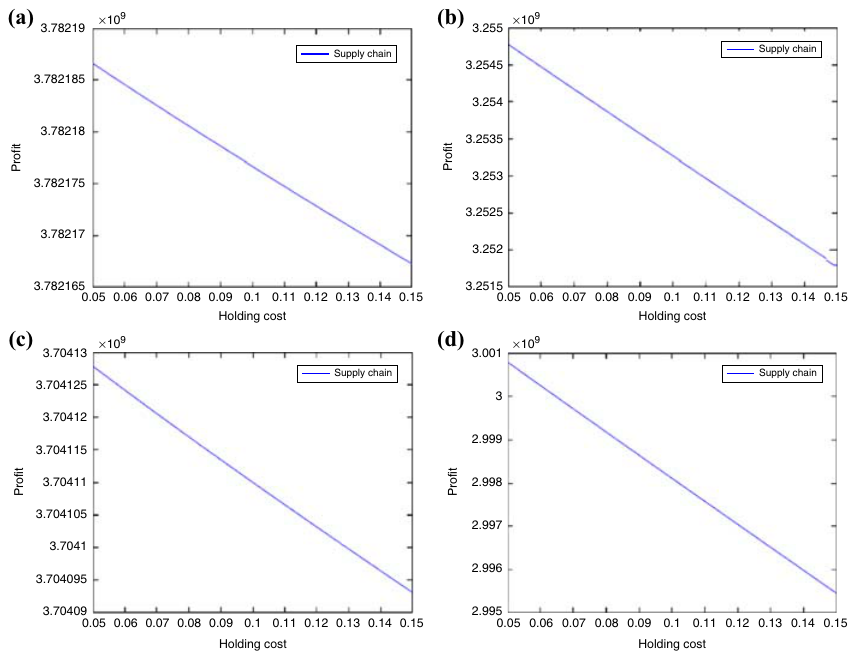
Figure 7. The impact of holding cost change on the profit of IBWT supply chain without/with fairness concern